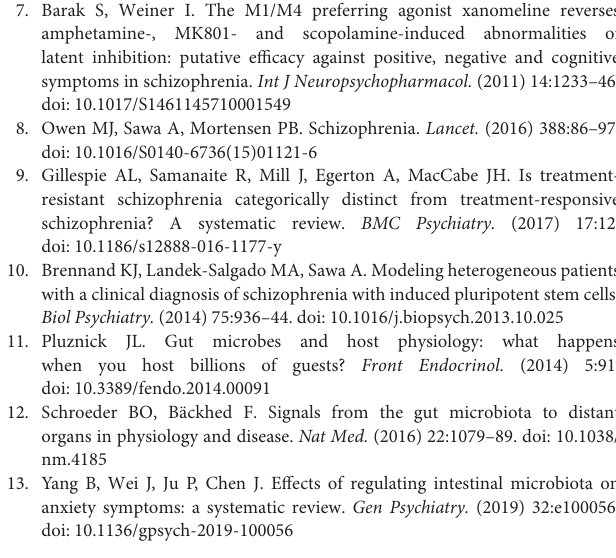
Supplementary Figure 1 | Results of the alpha-diversity of the faecal microbial communities in the acute stage group, Remission stage group and Healthy control groups. Six alpha metrics of Chao, Ace, Shannon’s diversity, Simpson’s diversity, Observed species and Good’s coverage indices were calculated, The P -values of those six metrics were all > 0.05. Alpha-diversity was no difference among the three